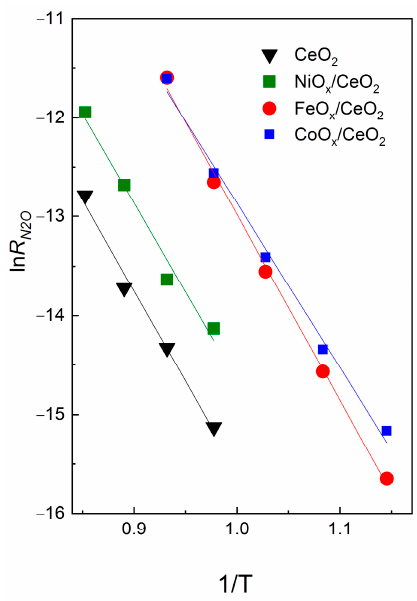
Figure 3. Rates of the reaction of N 2 O decomposition ( R N2O ) versus reverse temperature dependen- cies for different catalysts. Me concentration—0.86–0.91 wt.%. Inlet reaction mixture composition: 0.15%N 2 O in He. T = 600–900 °C. Table 2. Rates of the reaction of N 2 O decomposition ( R N2O ) and oxygen isotope exchange ( R , R II )